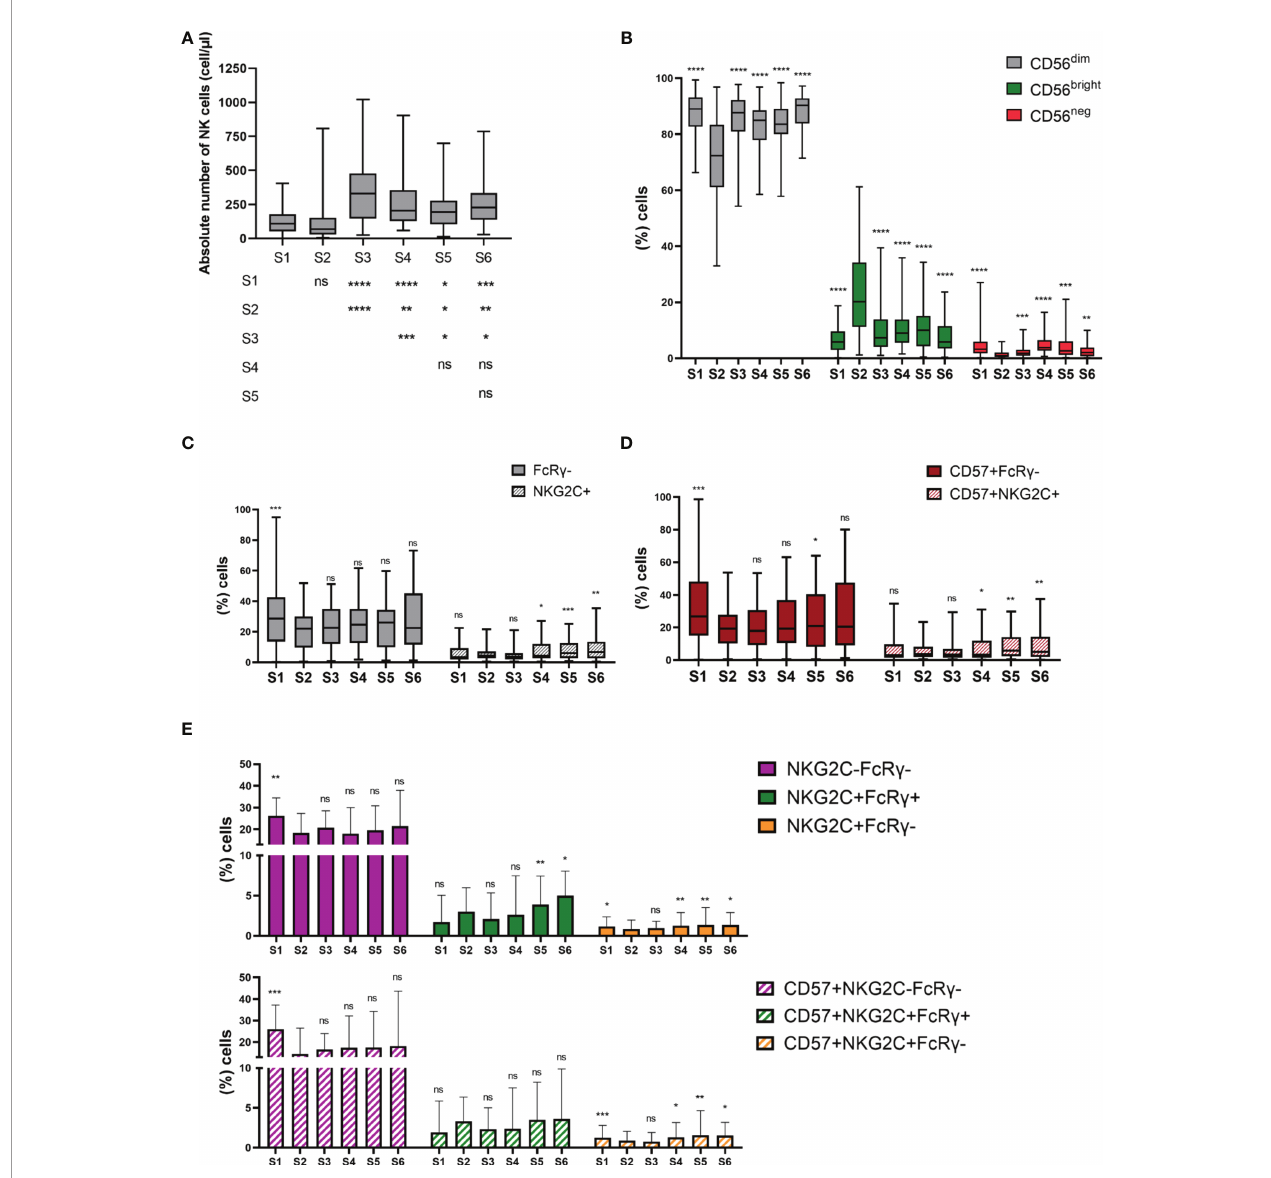
FIGURE 1 | NK cell subsets distribution is altered during NK cell reconstitution after autoHSCT. (A) Boxplot graphs showing the absolute number of NK cells at the six studied time points (S1-S6) (S1 n=52; S2 n=45; S3 n=43; S4 n=41; S5 n=33; S6 n=35). (B) Boxplot graphs showing the percentage of CD56 dim , CD56 bright and CD56 neg NK cells. (S1 n=54; S2 n=45; S3 n=45; S4 n=43; S5 n=37; S6 n=37) (C) Boxplot graphs showing the percentage of CD56 dim FcR g - and CD56 dim NKG2C+ adaptive NK cells (S1 n=54; S2 n=45; S3 n=44; S4 n=43; S5 n=37; S6 n=37). (D) Boxplot graphs showing the percentage of FcR g - and NKG2C+ adaptive NK cells within CD56 dim CD57+ NK cells (S1 n=54; S2 n=45; S3 n=44; S4 n=43; S5 n=37; S6 n=37). (E) Bar graphs showing the percentage CD56 dim NKG2C-FcR g -, CD56 dim NKG2C+FcR g + and CD56 dim NKG2C+FcR g - adaptive NK cells (upper panel) and NKG2C-FcR g -, NKG2C+FcR g + and NKG2C+FcR g - adaptive NK cells within CD56 dim CD57+ NK cells (bottom panel) (S1 n=54; S2 n=45; S3 n=44; S4 n=43; S5 n=37; S6 n=37). Boxplots show the median and 25 – 75th percentiles, and the whiskers denote lowest and highest values. Bar graphs show the median with the interquartile range. Signi fi cance of data was determined by comparing each sample with sample S2, except in (A) . *p < 0.05, **p < 0.01, ***p < 0.001, ****p < 0.0001 and ns, no signi fi cant (t test for paired values or Wilcoxon matched- pairs signed rank